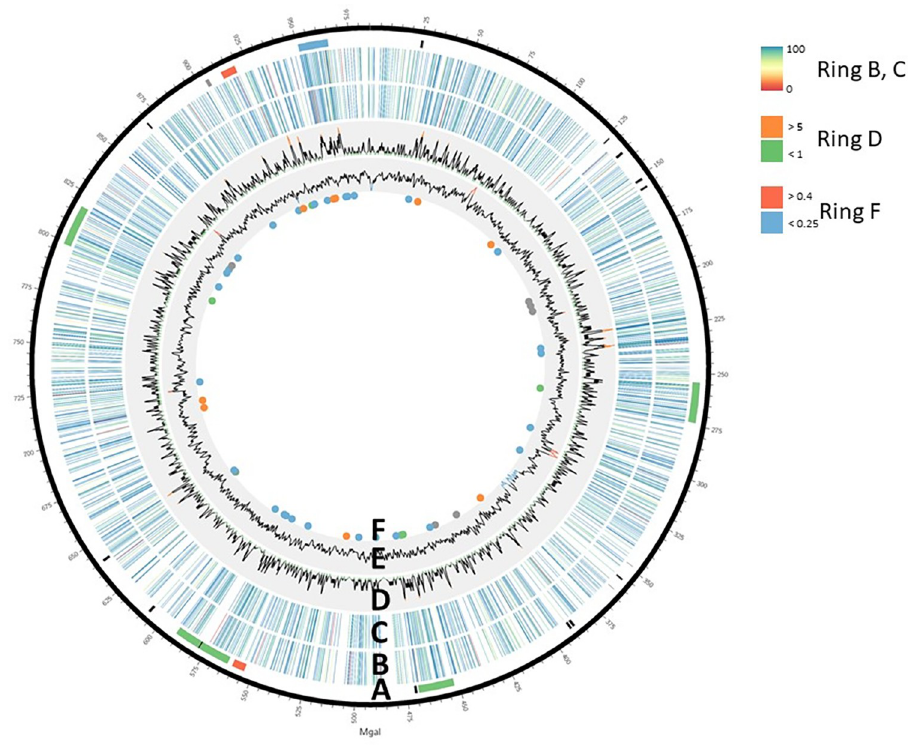
Fig 1. Distribution of DNA modification sites along the genome of M . gallisepticum S6. A–Annotated features: RM systems are in orange, vlhA clusters in green, the CRISPR system in grey, the virulence cluster in blue, and mobile elements in black. B and –Whole-genome representation of the DNA modification motif ANCNNNNCCT for plus and minus strand, respectively. The lines indicate positions of sites, and the colors from red to blue represent percentage of methylation in each site. Percentage of methylation was calculated using the build-in SMRT protocol, as the fraction of reads aligning to the position that has a modified base. D–Density of methylation sites. Maximum density of methylation is highlighted in orange, while minimum is highlighted in green. E–GC content. Maximum GC content is highlighted in red, while minimum is highlighted in blue. F–Hypo-methylated sites are in green, hemi- methylated sites in orange and blue (for plus and minus strands, respectively); proteins with differential abundance (as assessed using 2D-DIGE) between WT and Δ S.MgaS6I strains are in grey.